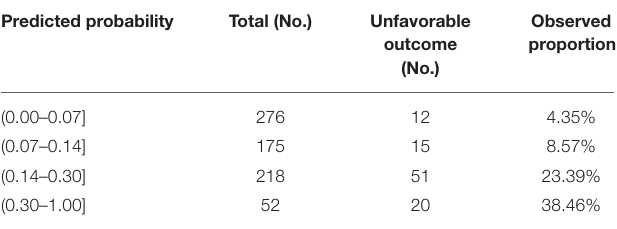
Observed outcome (No.)